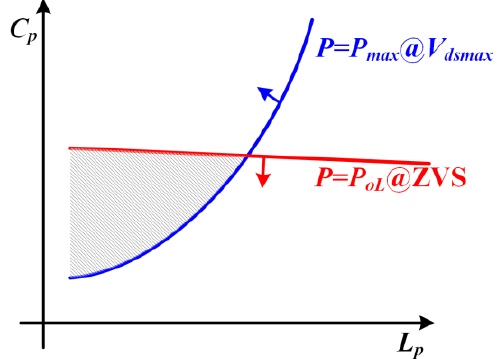
Figure 6. Input power P in as a function of primary self-inductance L p and parallel-resonant capaci- tance C p , illustrating the boundaries of ZVS and maximum drain-to-source voltage V DSmax . The blue line indicates the L p and C p parameter combination when the load power reaches P max and the drain-to-source voltage is fixed to V DSmax . The red line indicates the L p and C p parameter combination when the load power reaches P oL with critical ZVS conditions satisfied. As seen in the figure, the shaded area is the operating region satisfying both the maximum power requirement and the constraint of light load ZVS. Within this range, the larger the L p , the smaller the primary current, which is conducive to reducing the current stress of the power semiconductor and the compensation capacitor, and beneficial to reduce the loss of resistance and improve conversion efficiency. Therefore, the optimized operation point can be selected at the right vertex of the